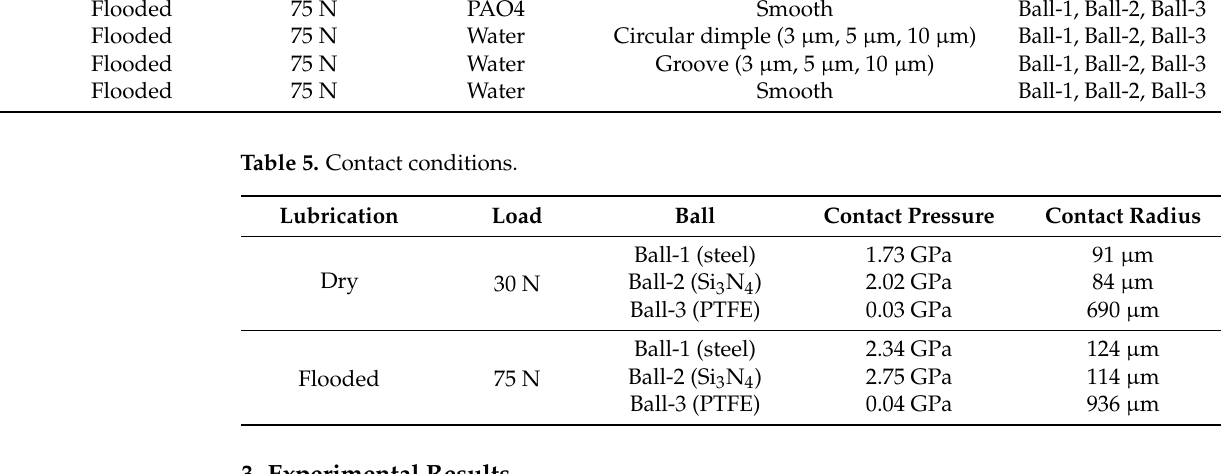
Table 5. Contact conditions.